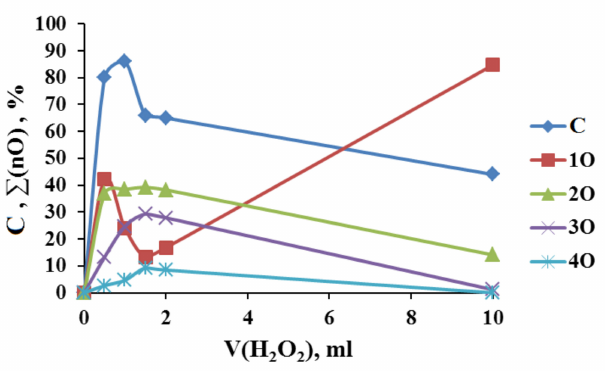
Figure 3. The 0 conversion (C) and the sum ( Σ ) of the products of its n -oxygenation, where n = 1–4, in dependence on the volume V(H 2 O 2 ) of the oxidizing